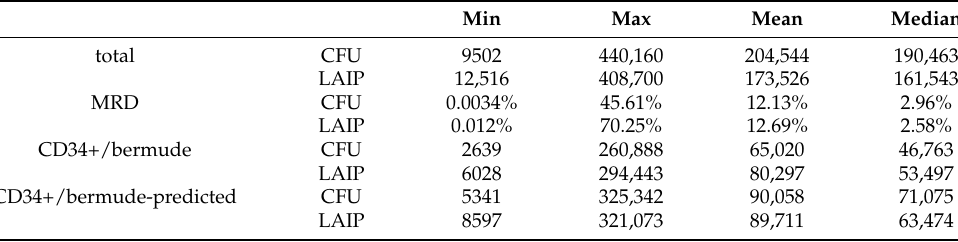
Table A5. Statistical summary of the amount of events and MRD percentage in the test data set used. CD34+/bermude and CD34+/bermude-predicted denote the statistics for CD34 positive events and events falling into the bermude area (CD34 neg) based on the ground truth and prediction by the Set-Transformer,